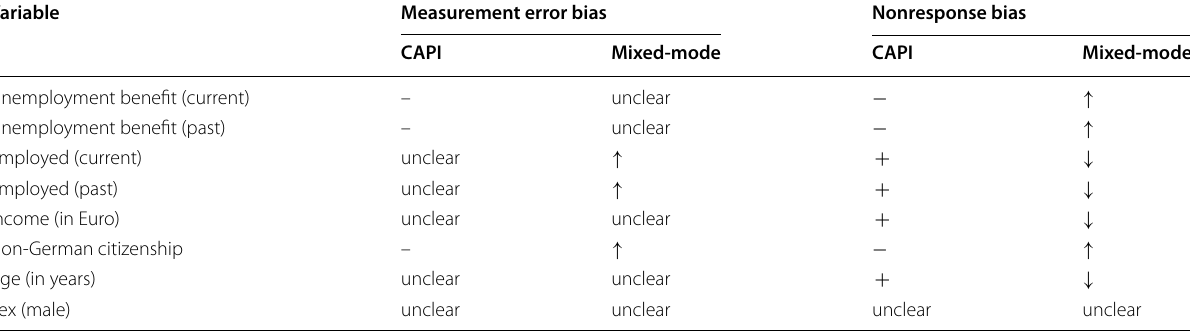
Table 1 Summary of expectations for each variable